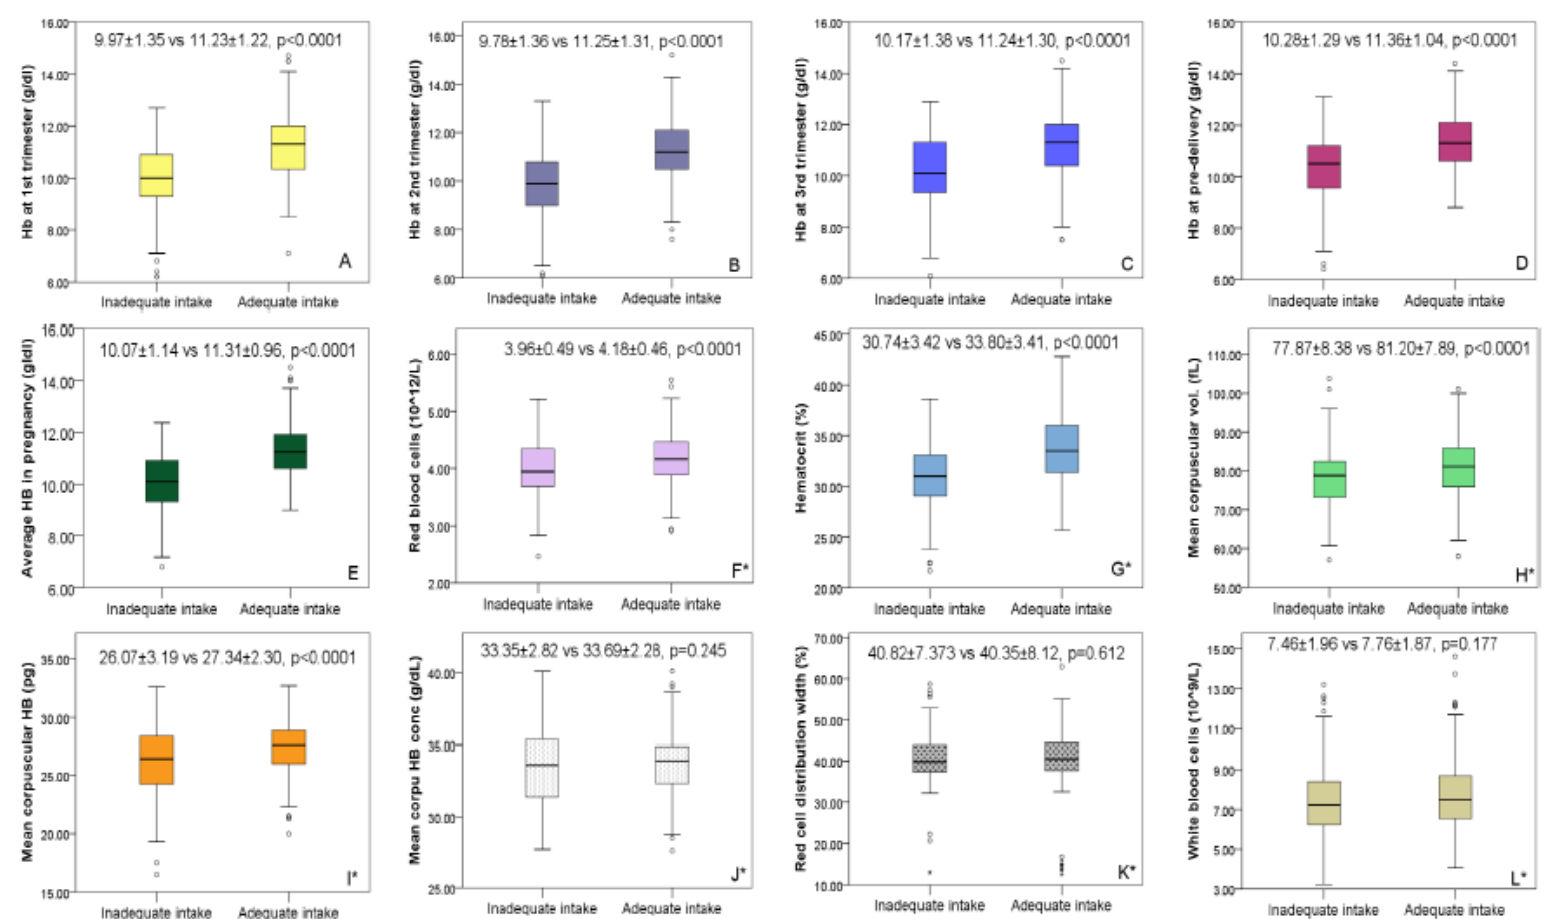
Figure 1. Inter-quartile and mean values for hemoglobin and other red blood cell indices classified according to the adequacy of micronutrient intake. * RBC indices were measured only in the second trimester. Footnote: Hemoglobin in the ( A ) first, ( B ) second, ( C ) third trimesters of pregnancy and ( D ) at the point of admission for labor and delivery, ( E ) mean hemoglobin during pregnancy, ( F ) red blood cells ( G ) hematocrit, ( H ) mean corpuscular volume, ( I ) mean corpuscular hemoglobin, ( J ) mean corpuscular hemoglobin concentration, ( K ) red cell distribution width and ( L ) white blood cells.